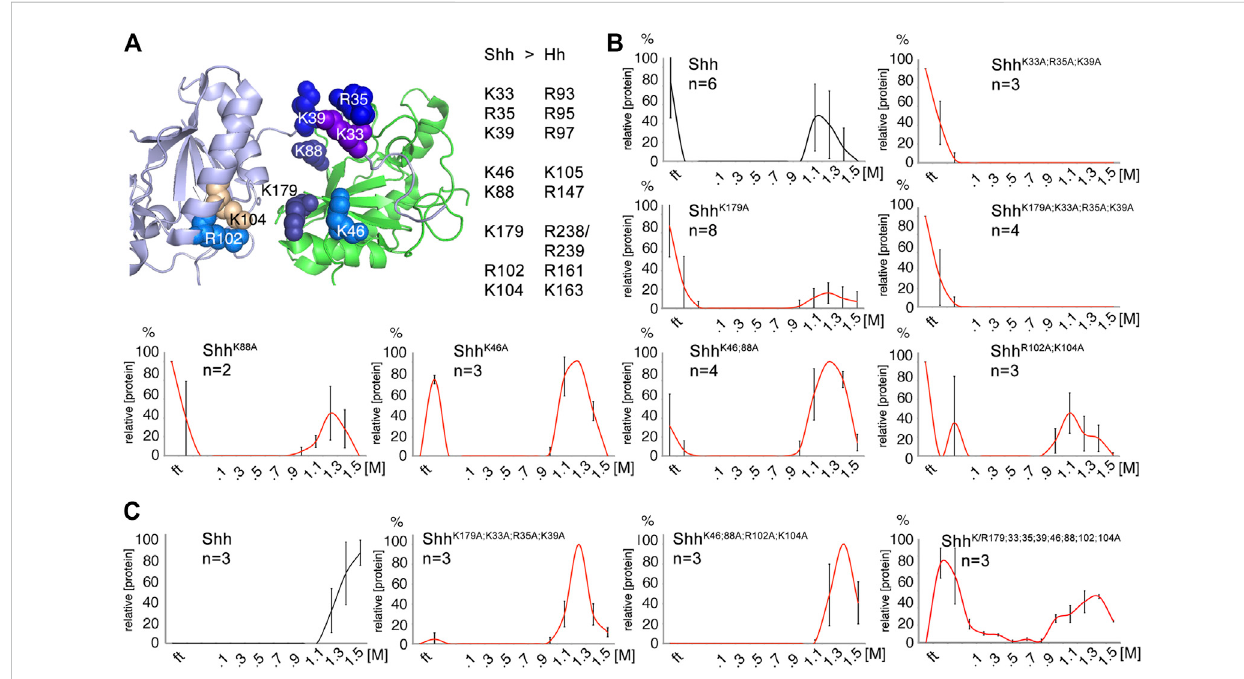
FIGURE 2 HSandheparinaf fi nitychromatographyofShh. (A) Heparin-bindingaminoacidsandtheirlocationinhumanShh(PDB:3m1n)(Pepinskyetal.,2000) areshown.TheCardin-Weintraub(CW)motif(Rubinetal.,2002)includesresiduesK33,R35,andK39(Farshietal.,2011).ResidueK179(Changetal.,2011) and residues K88, R124, R154, and R156 (Whalen et al., 2013) are also highlighted. Residue K46 is located in close proximity to these established residues, suggestingapossiblecontributiontoheparinbinding.ResiduesR102andK104locatedistantfromestablishedHSbindingsitesandserveascontrols. (B) HS mixtures derived from 2 independent pools of mouse embryos were coupled to FPLC columns and Shh binding to these matrices analyzed. Shh (black line)boundtoembryo-derivedHS, but bindingofmutantproteins (redlines) lacking CWaminoacids K33, R35,and K39wascompletely abolished. The relative amount of HS-binding Shh K179A proteins was reduced. Note that, despite their different interaction dynamics, all proteins eluted from the HS matrix at similar salt concentrations. (C) Additional basic residues contribute to the binding of all Shh variants to highly sulfated heparin. Unlike for HS, proteinassociationtoheparinisfast,asindicatedbyabsenceofproteinsinthe fl ow-through(ft),butproteinsprogressivelyappearinthe fl ow-throughas more of the positively-charged residues were mutated (bottom right). The number of independently conducted experiments and standard deviations between the experiments are shown in the graphs. Black line: Shh, red lines: Shh variant proteins. See Table S1 for exact statistical